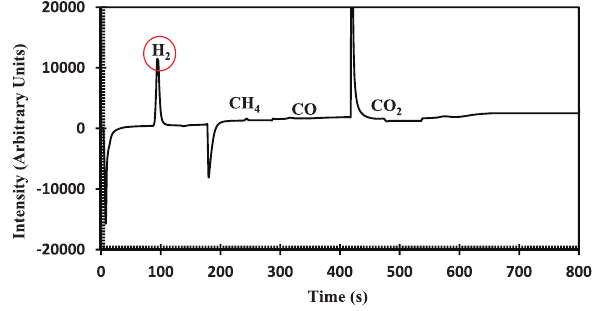
Fig. 9: Gas chromatogram obtained after 60 s of heating HDPE-alumina